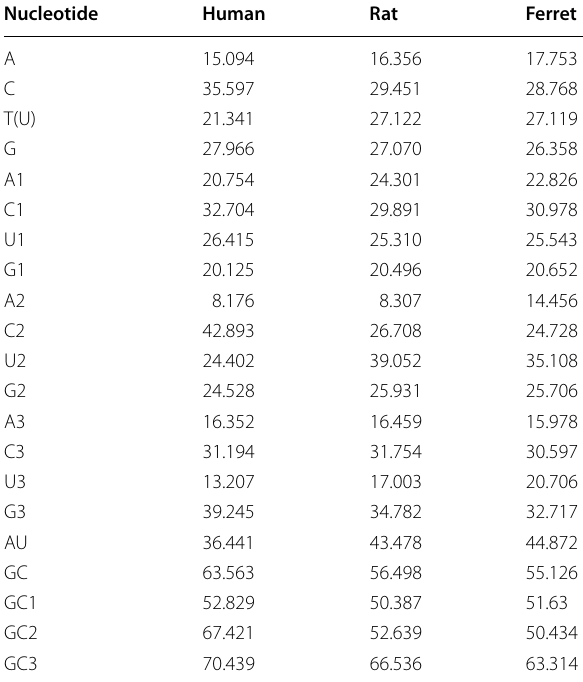
Table 1 Nucleotide composition analysis of ORF4 of hepatitis E